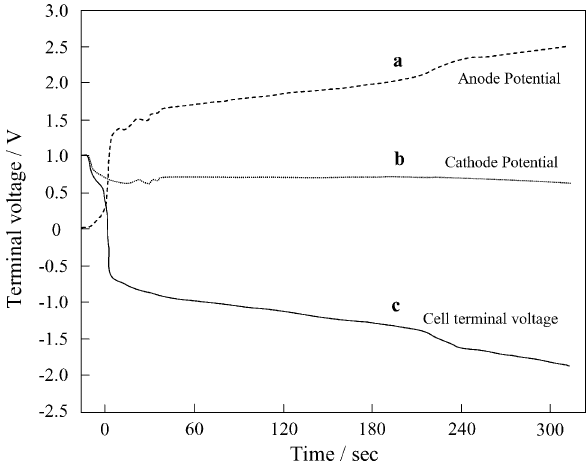
Fig. 2. The time-dependent changes of the anode and cathode potential Figure 1. Anode and cathode potential change experienced cell reversal caused by hydrogen starvation. during the cell reversal experiment. Reproduced with permission from [6]. Copyright Elsevier,